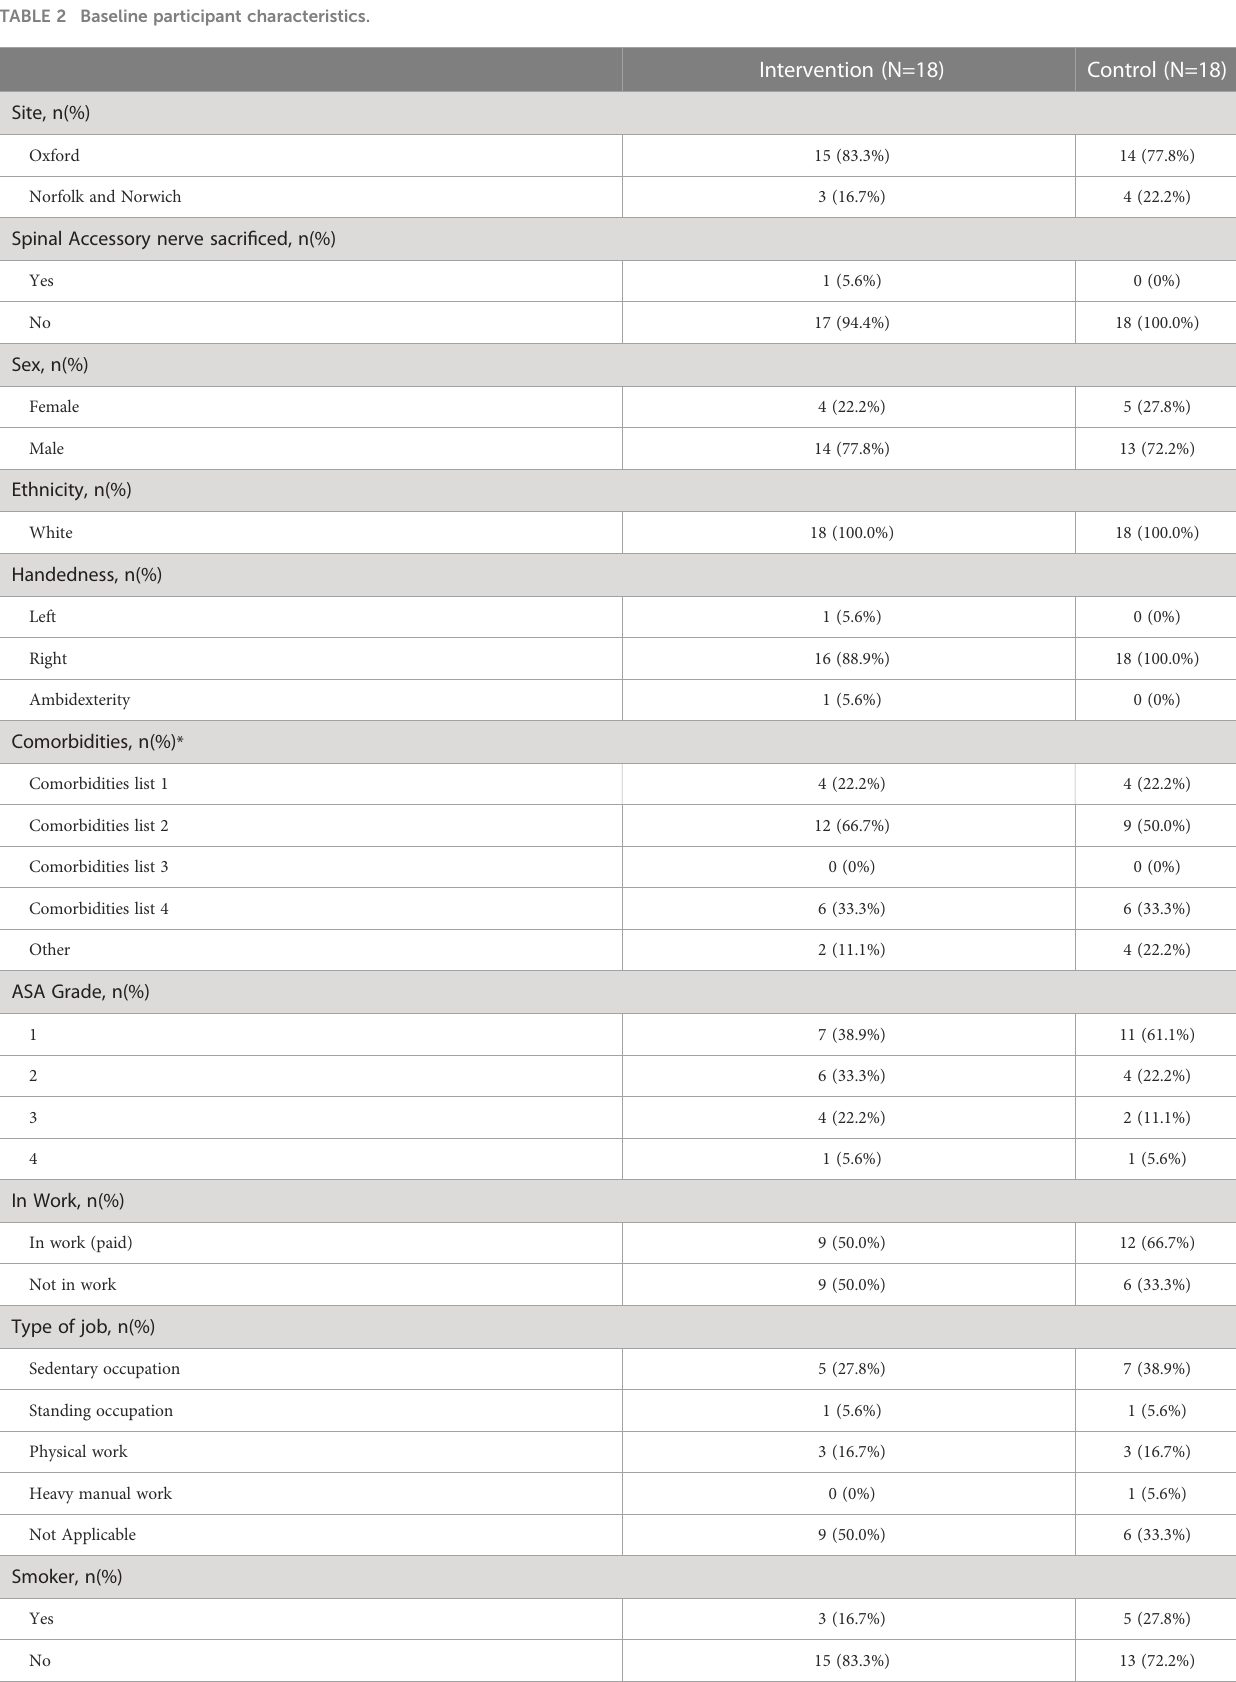
TABLE 2 Baseline participant